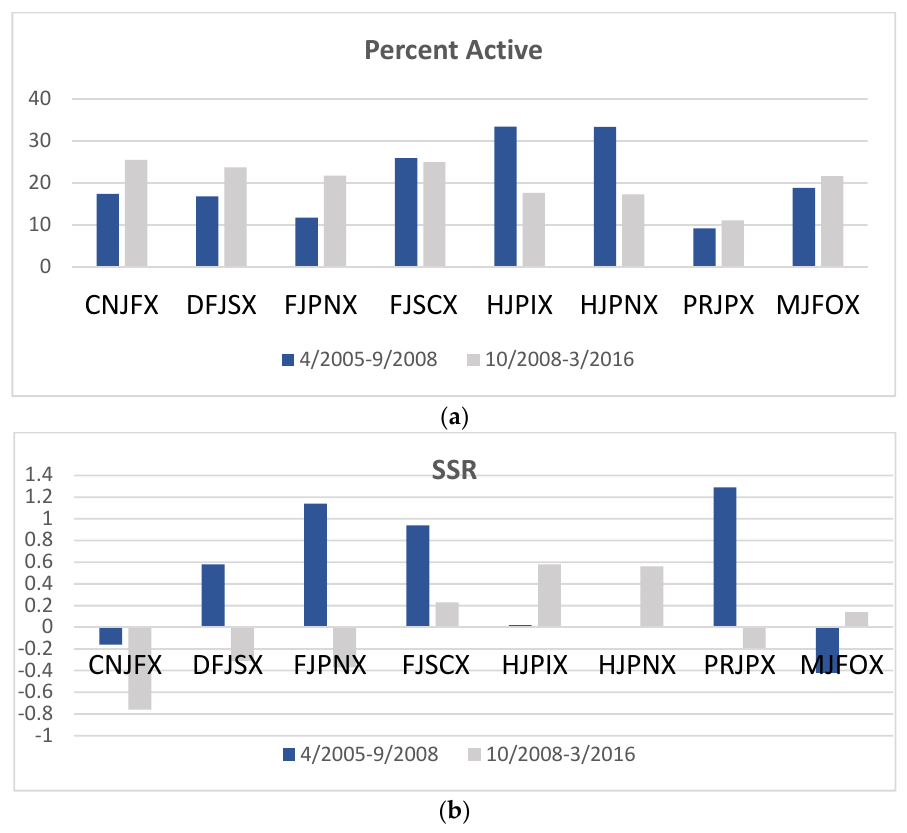
Figure 11 . SSR and percent active before and after the 2008 crisis. (a) Percent Active (b) Selection Sharpe Ratio. Figure 11. SSR and percent active before and after the 2008 crisis. ( a ) Percent Active ( b ) Selection Percent Active is expressed in percentages; SSR is expressed in absolute values. Sharpe Ratio. Percent Active is expressed in percentages; SSR is expressed in absolute